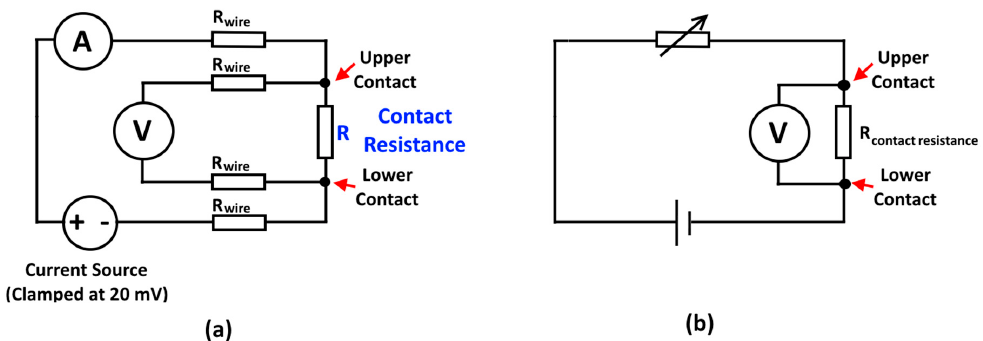
Figure 3. ( a ) Contact Resistance Measurement Circuit and ( b ) Contact Load Circuit.